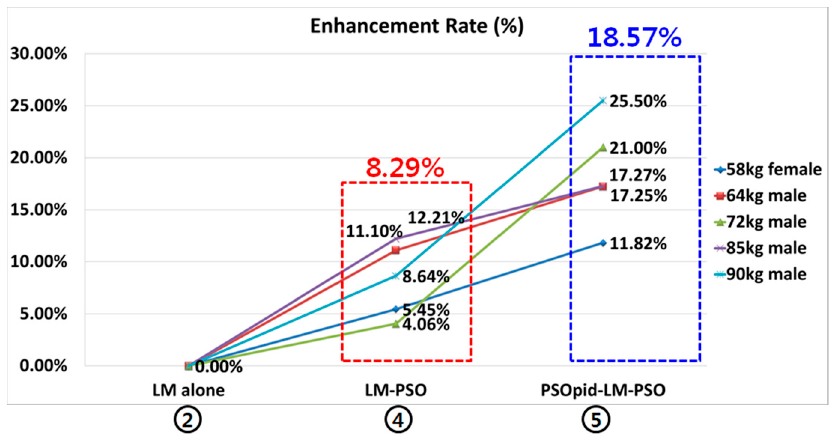
Figure 8. Enhancement graph of each algorithm as compared to the classic LM-based backpropagation algorithm.